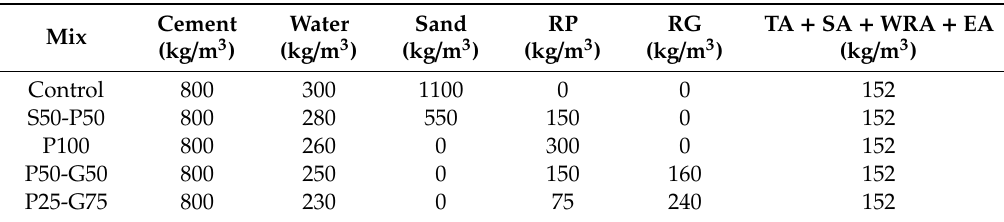
Table 3. Cement-based mixes